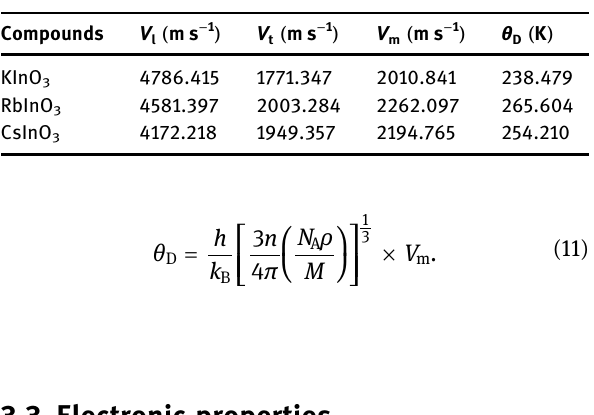
Table 4: The longitudinal ( V l ) , transverse ( V t ) , and average ( V m ) wave velocities and Debye temperature ( θ D ) for XInO 3 ( X = K, Rb, and Cs ) compounds